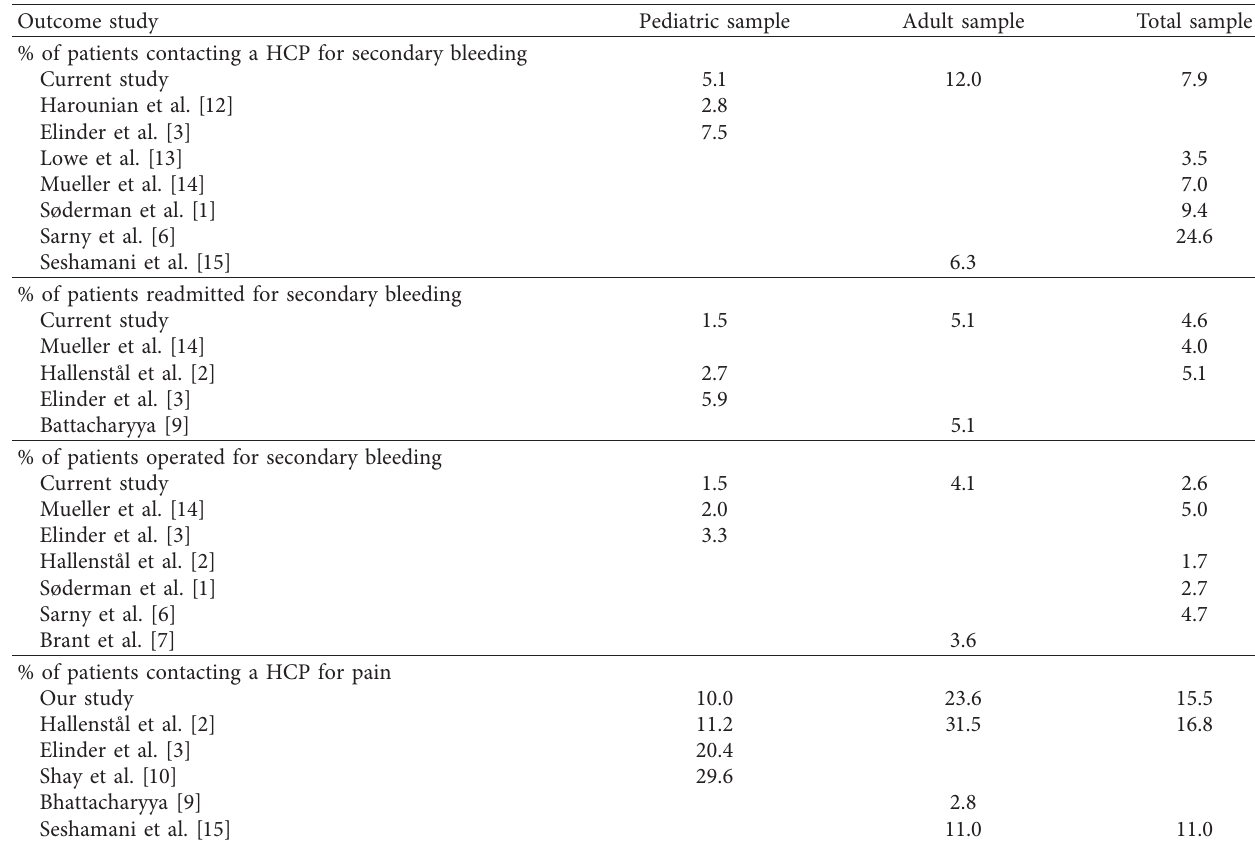
Table 4: Comparison of postoperative complication rates in recent studies by age group and for the total